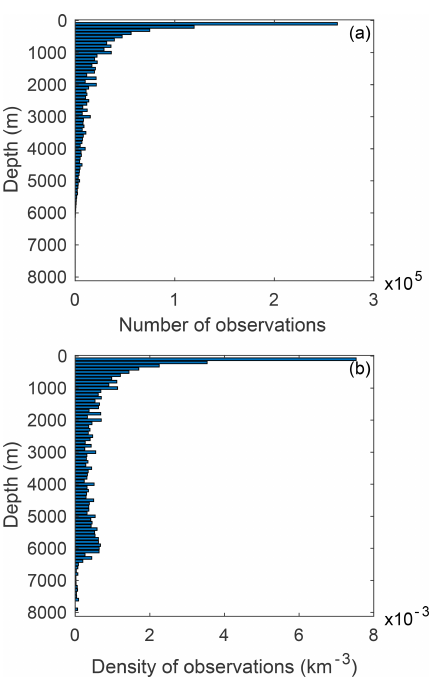
Figure 8. Number (a) and density (b) of observations in 100m depth layers. The latter was calculated by dividing the number of observations in each layer by its global volume calculated from ETOPO2v2 (National Geophysical Data Center, 2006). For exam- ple, in the layer between 0 and 100m there are on average 0.0075 observations per cubic kilometer. One observation is one water sam- pling point and has data for several variables.